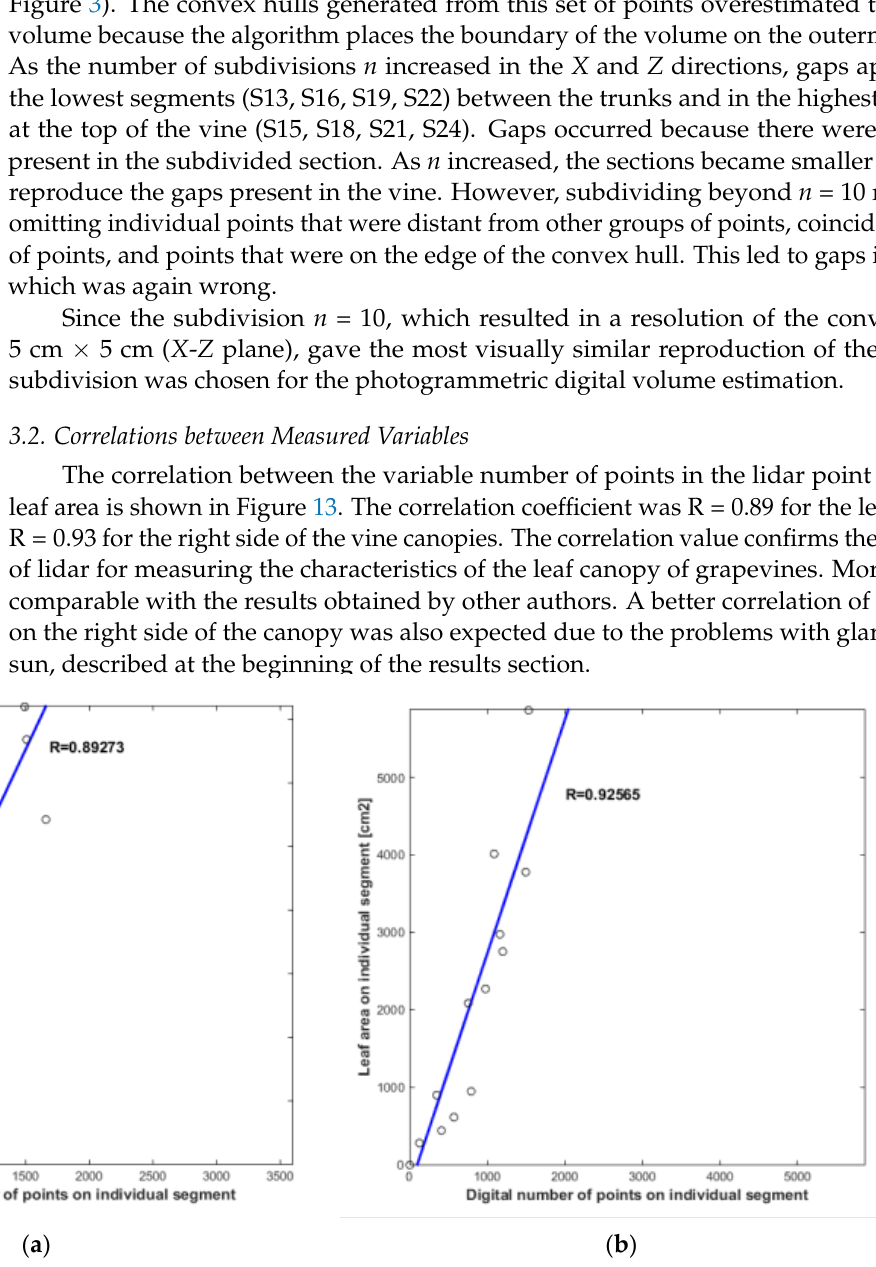
segment (manual measurements): ( a ) left side of canopy and ( b ) right side of canopy. Correlation